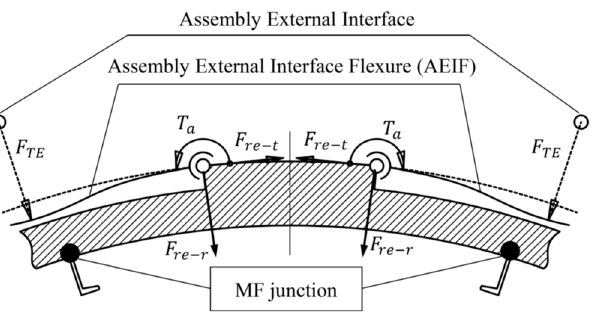
Figure 12. ETCML-induced AEIF deflection and equivalent load components at the AEIF end pivot. Effects of the groove semi-arc angle on the ETCML magnitude at the external interface, the ETCML induced reaction force at the mirror support point, and the ETCML transfer factor have been evaluated using FEA. The BP is assumed to be externally connected with the thermally expandable rigid SH and internally fixed at each MF center pad. The ETCML, and the ETCML-induced reaction force due to 35 °C temperature variation and CTE mismatch of aluminum-made SH and titanium-made BP, are investigated. Relationships between the groove semi-arc angle ( θ ) and the ETCML ( F TE ), the ETCML induced reaction force ( F TE − r ), and the ETCML transfer factor ( β ) are illustrated in Figure 13.